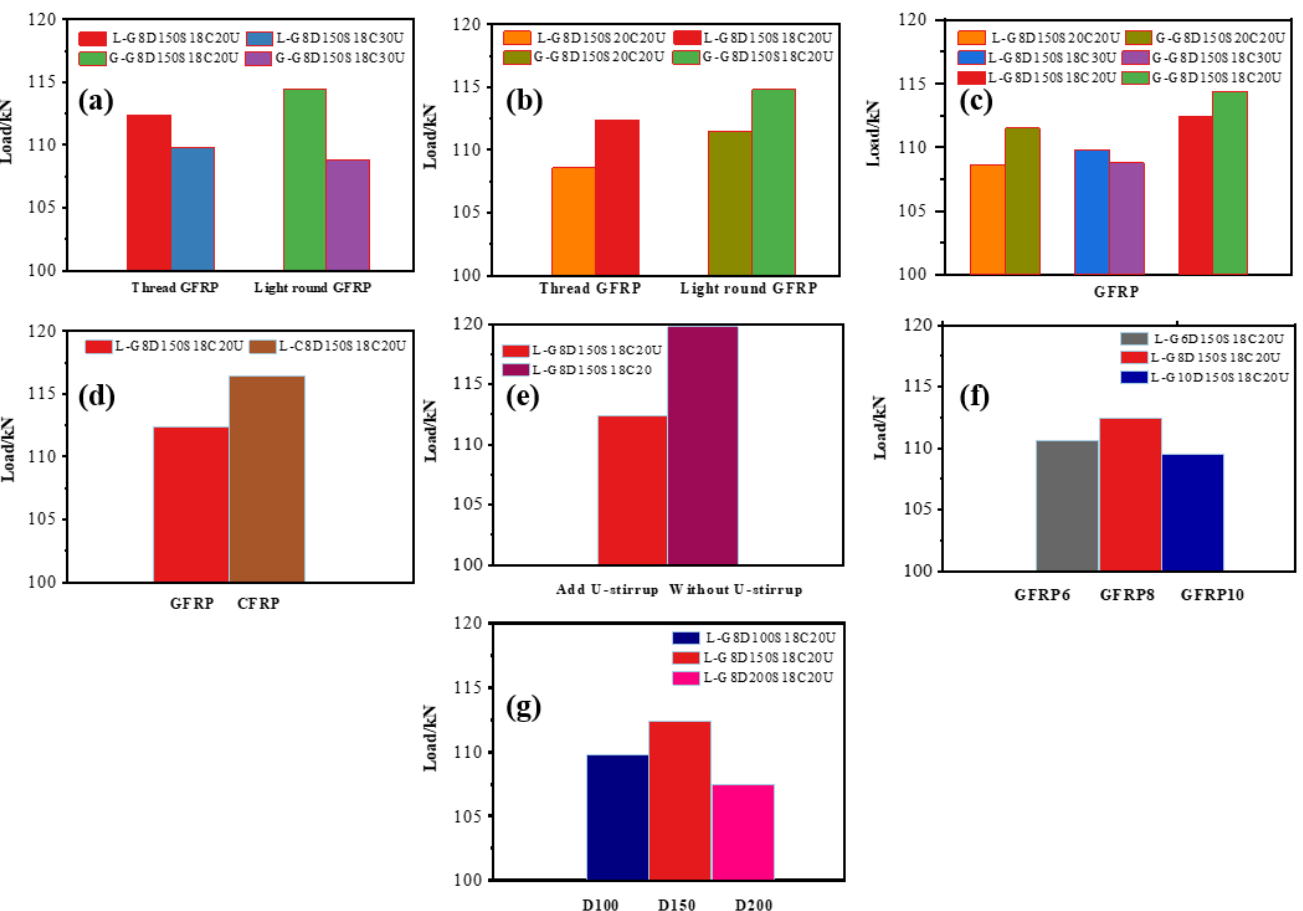
Figure 6. Influence of different parameters on bearing capacity of specimens. (a) concrete strength grade, (b) the longitudinal reinforcement ratio, (c) CFRP surface characteristics, (d) FRP type, (e) the reinforcement method, (f) the GFRP diameter and (g) the GFRP spacing.